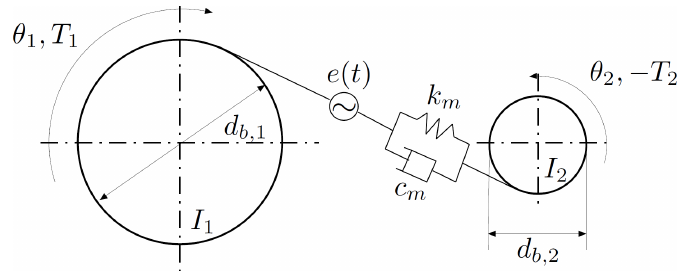
Figure 7. Ozguven and Houser dynamic model as detailed in [95].